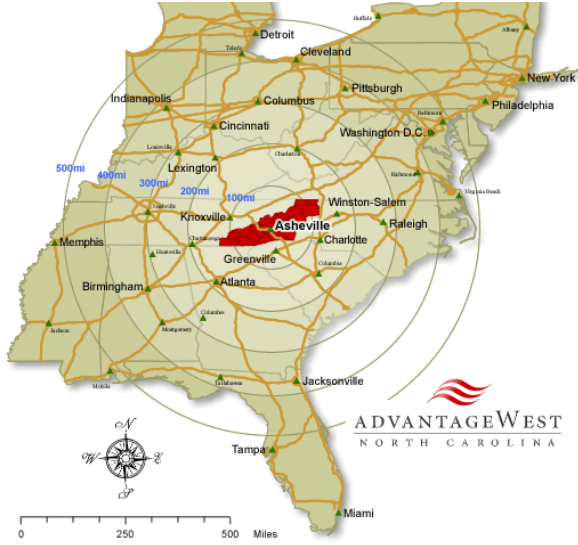
Figure 1. Western Carolina University is in the southern most exten- sion of rural